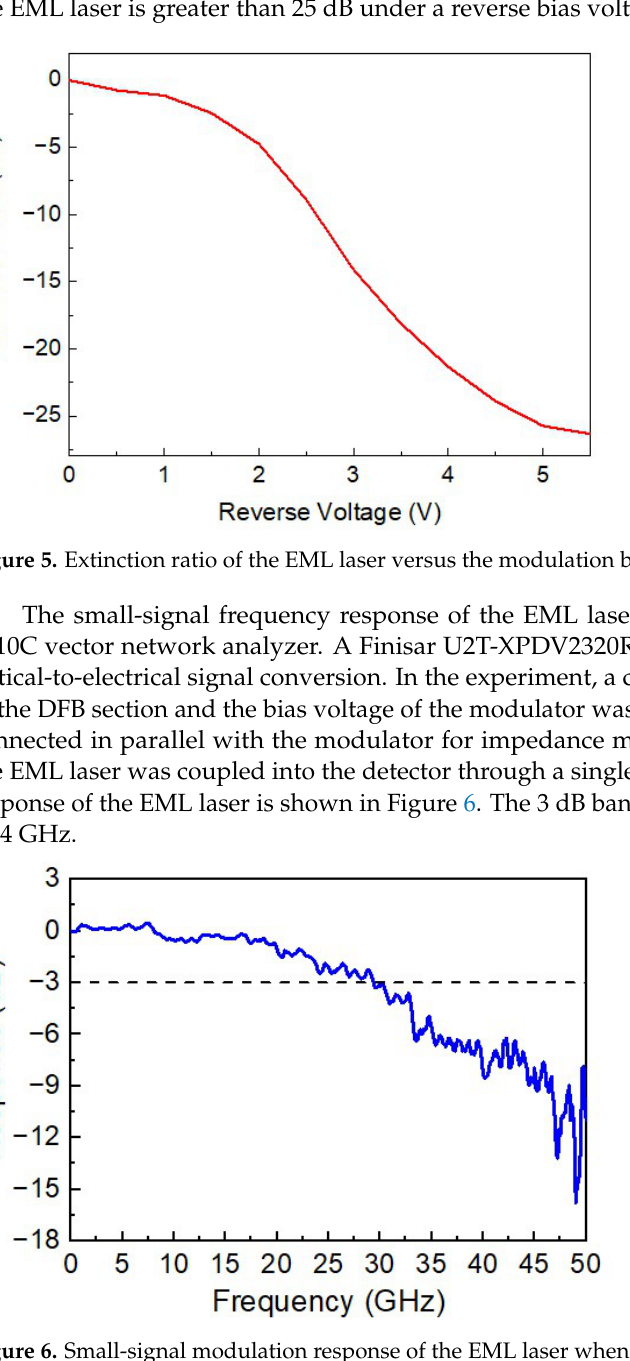
4 of 7 Figure 4. Typical optical spectrum of the DFB section of the EML laser at 70 mA. Figure 5 shows the static extinction ratio characteristics of the EML laser. During the test, the current of the DFB section was fixed at 70 mA and the reverse voltage applied to modulator was varied. The light of the EML laser was coupled to an optical power meter through a single-mode fiber. From Figure 5, it can be seen that the static extinction ratio